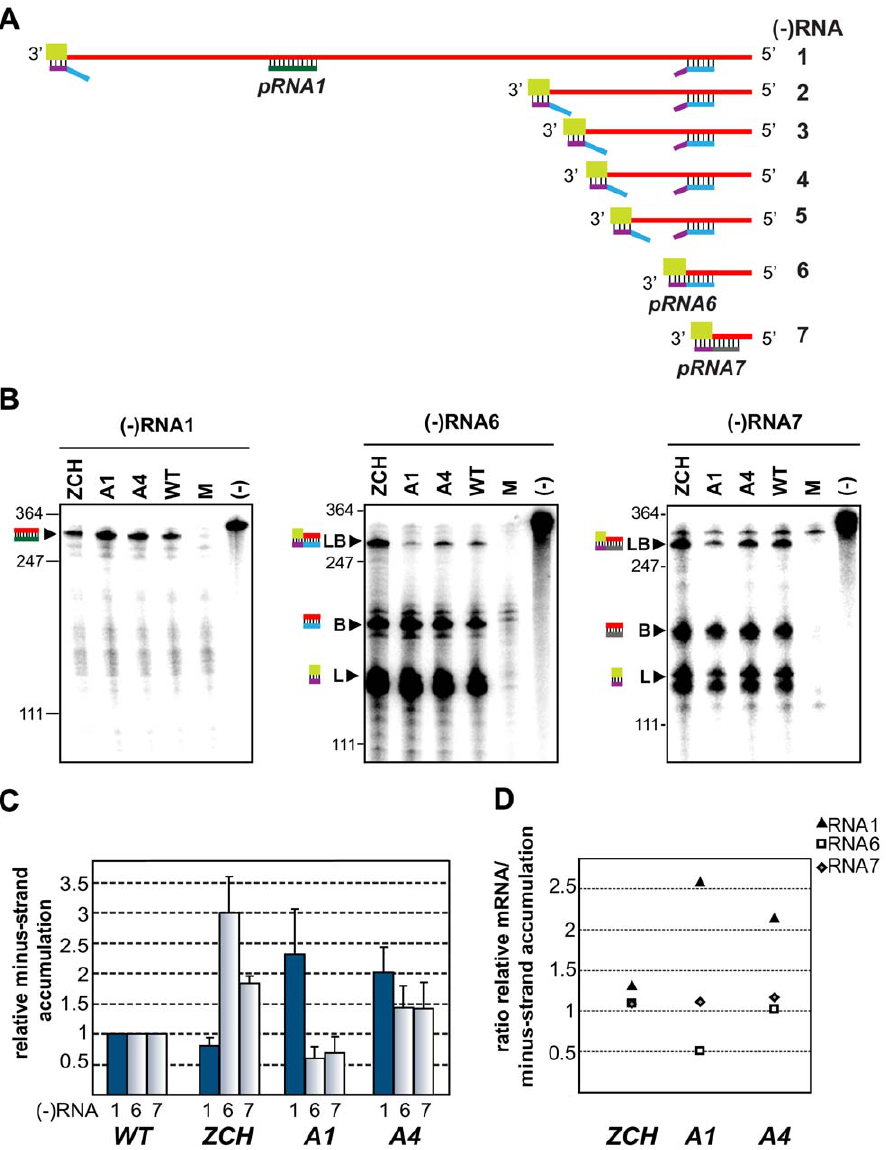
Figure 5. Minus-strand RNA accumulation is also modulated by mutations in nsp1. (A–D) Analysis and quantification of EAV minus-strand accumulation by a two-cycle RNase protection assay. (A) Schematic representation of the nested set of viral minus-strand RNA [( 2 )RNA] species produced in EAV-infected cells. The anti-leader sequence is depicted in light green. The in vitro-transcribed plus-strand probes used for detection of ( 2 )RNA1 (pRNA1), ( 2 )RNA6 (pRNA6) and ( 2 ) RNA7 (pRNA7) are shown. pRNA6 and pRNA7 target the leader-body junction sequences of ( 2 )RNA6 and ( 2 )RNA7, respectively. Note that hybridization with pRNA1 results in the protection of a single fragment, while the probes for ( 2 )RNAs 6 and 7 each protect three fragments – one derived from the full-length sg minus strand, and two fragments derived in part from partial hybridization of these probes to larger viral ( 2 )RNAs in which the target sequences are noncontiguous (exemplified for pRNA6). For simplicity, non-EAV sequences present near the termini of the three probes were omitted from the scheme. (B) Viral ( 2 )RNA accumulation was analyzed at 11 h post-transfection for the ZCH, A1 and A4 mutants, and a wt control. Protected fragments were resolved on denaturing 5% polyacrylamide/8M urea gels and visualized by phosphorimaging. The constructs analyzed are labeled above the lanes (M, mock-transfected cells; ( 2 ), no-RNase control that shows a band corresponding to 0.2 fmol of the full-length probe). Sizes (nt) of RNA markers have been indicated on the left. The single 327-nt protected fragment resulting from hybridization with the positive-sense probe for RNA1( 2 ) is indicated. The probes for subgenome-length minus strands protected fragments derived from the full-length ( 2 )RNA6 and ( 2 )RNA7 (327 nt and 319 nt, respectively; denoted with LB), as well as from the ( 2 )RNA6 and ( 2 )RNA7 body sequences (188 nt and 180 nt, respectively; denoted with B) and the anti-leader sequence (139 nt; denoted with L). The presence of two bands in the size range of the anti-leader fragment has been described previously [55]. (C) The relative levels of minus-strand accumulation were quantified by phosphorimaging. For ( 2 )RNAs 6 and 7, only the bands resulting from protection of full-length sg minus strands (denoted with LB in panel [B]) were quantified. The values correspond to the means from three independent transfections that were normalized to the level of accumulation of each minus-strand RNA in the wt control, which was set at 1. Intracellular RNA from the same transfection samples for which plus- strand accumulation was quantified (Fig. 4B) was used. Genomic minus-strand RNA levels are represented as dark blue bars. Error bars denote standard deviation. (D) The ratio of plus-strand to minus-strand accumulation for RNAs 1, 6 and 7 was calculated using the mean relative values obtained in Fig. 4B and Fig. 5C.